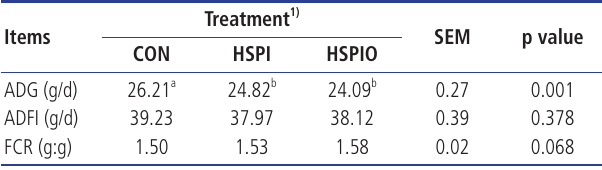
Table 4. Growth performance of broilers fed basal diet, heat-oxidized SPI diet or heat-oxidized mixture of SPI and 2% soybean oil